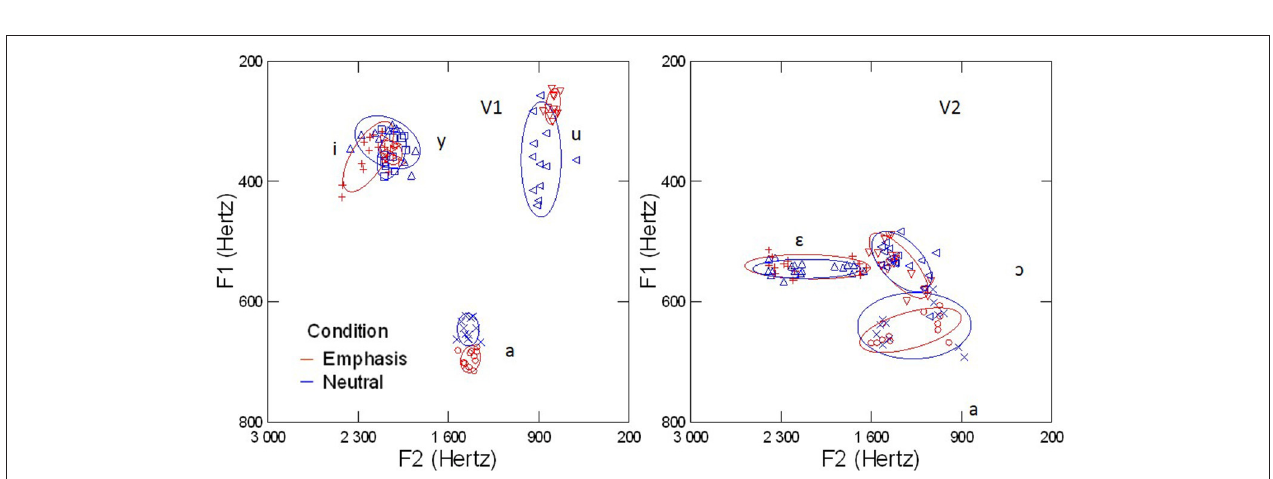
FIGURE 3 | F1 and F2 values for the first vowel of the target word (V1, Left ) and for the second vowel of the target word (V2, Right ), for contrastive focus and neutral conditions. Ellipses enclose 95% of the dispersion.